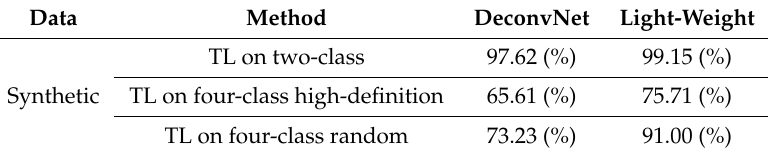
Table 3. Segmentation accuracy on the synthetic dataset. TL—Transfer